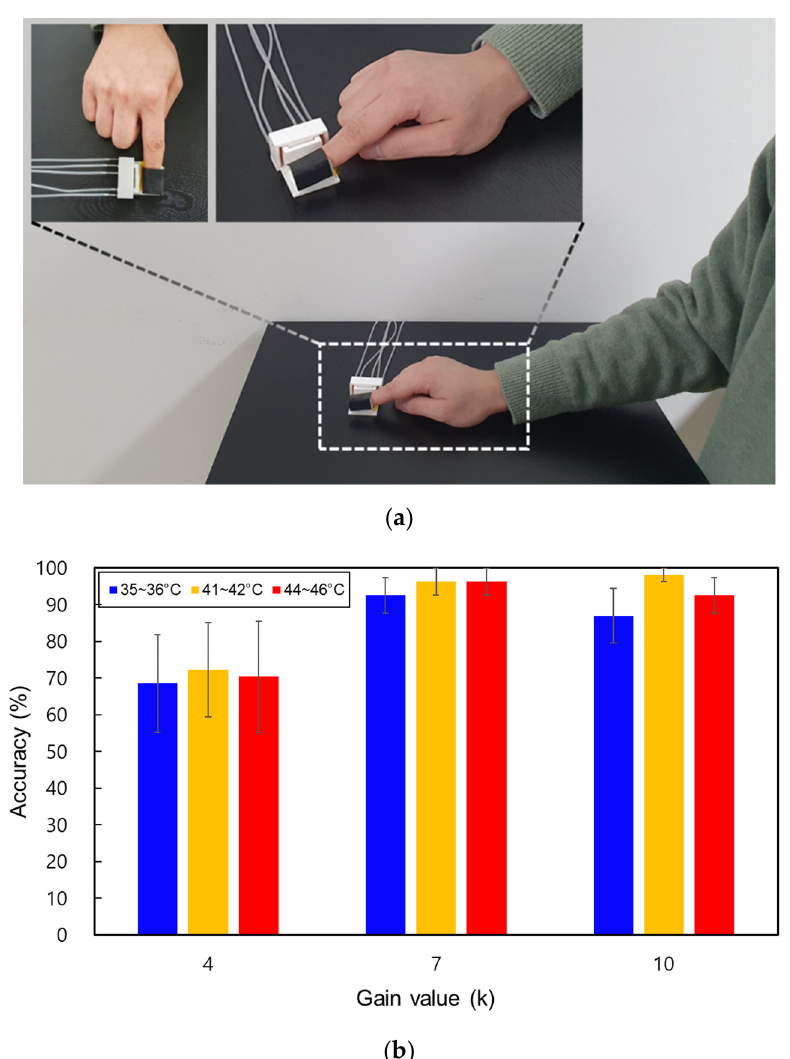
Figure 13. Setup for psychophysical experiments ( a ) and accuracy measured at various heater temperatures ( b ).